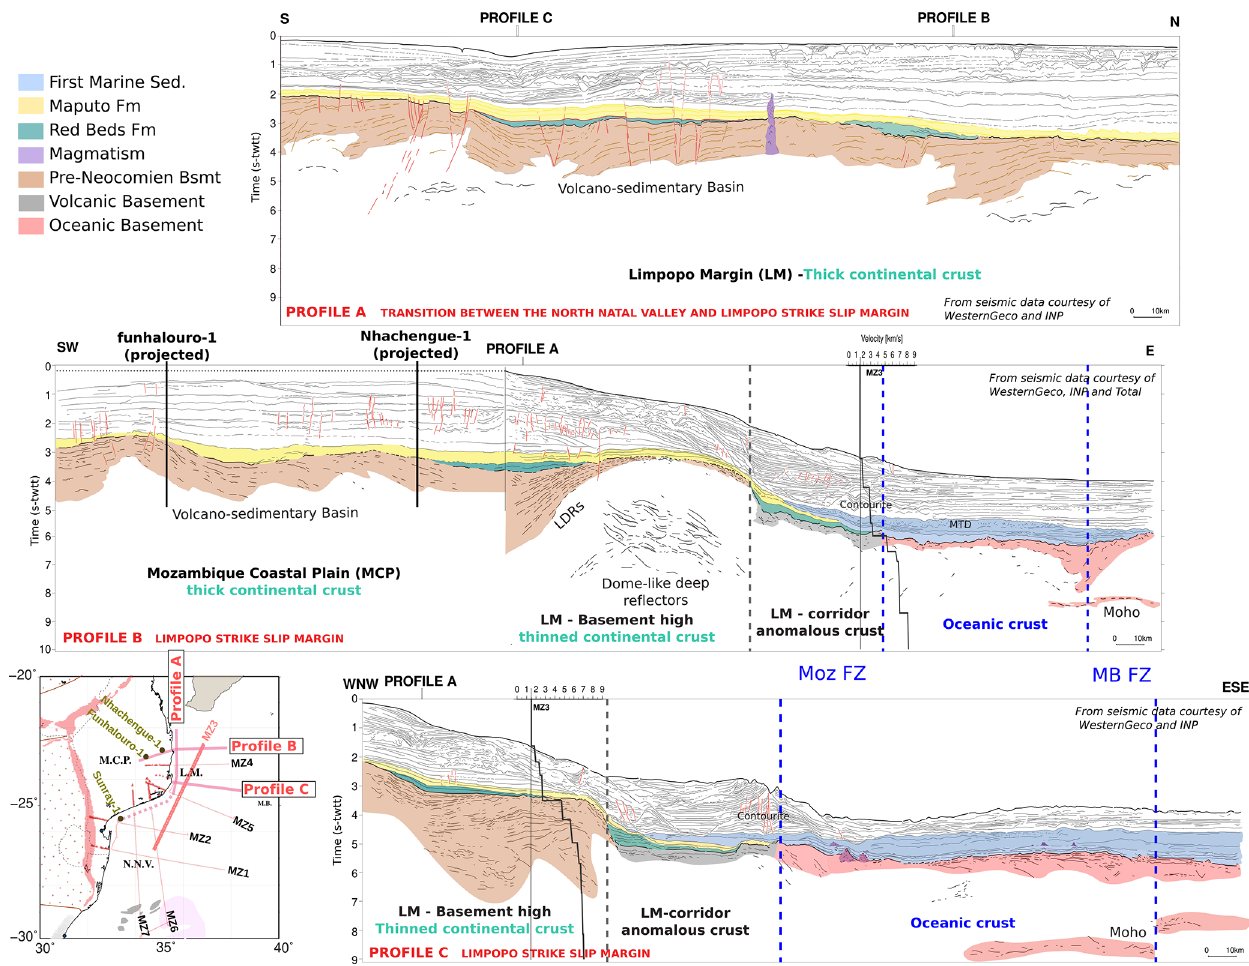
Figure 14. Compilation of line drawing of commercial MCS two-way travel time profiles superimposed by stratigraphic interpretation. The map in the bottom-left corner gives the locations of these profiles with respect to seismic profiles acquired during the PAMELA MOZ3-5 cruise. Also reported are drills locations that help to constrain ages of early sedimentary deposits. We also plotted velocity versus depth profiles at locations where profiles B and C cross the MZ3 velocity